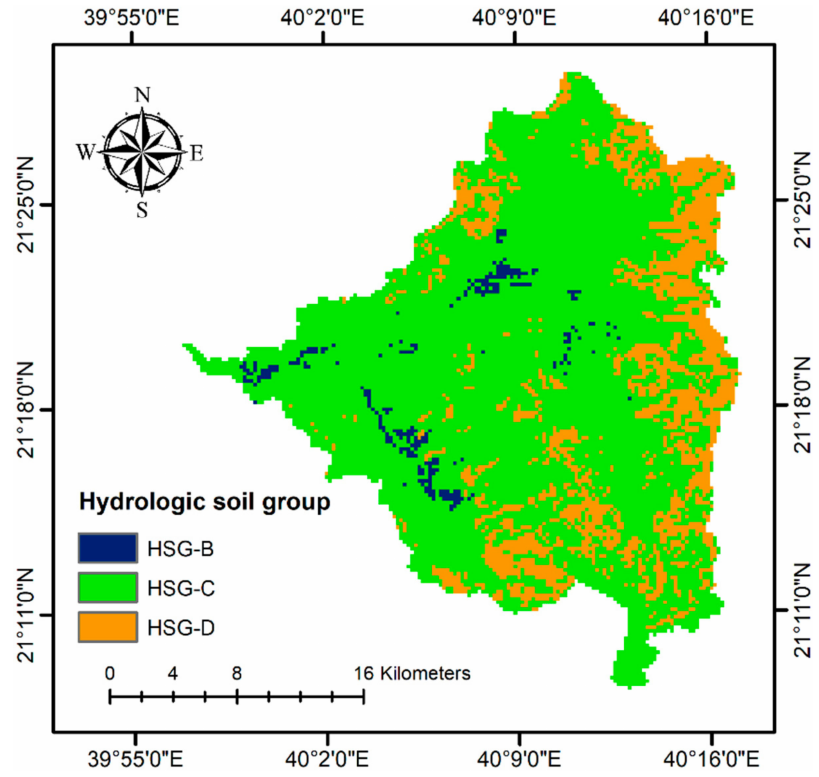
Figure 7. Hydrologic soil group (HSG) map of the study region.